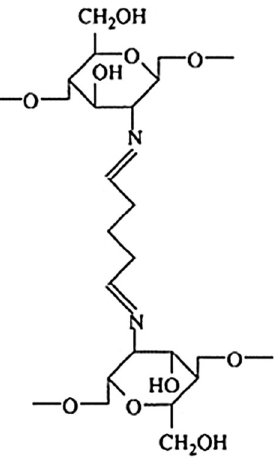
Fig. 4 Possible structure formed from crosslinking, using glutaralde-